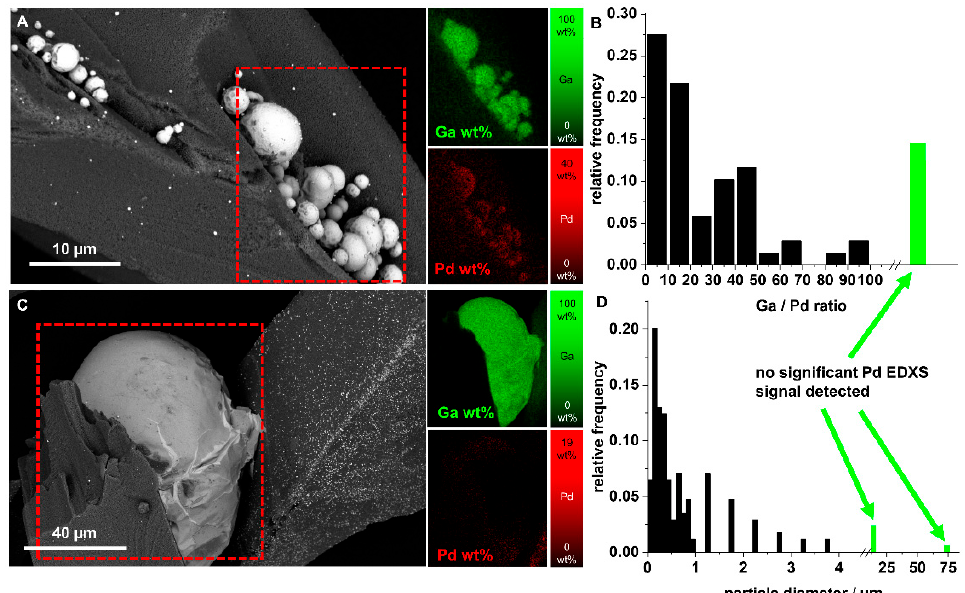
Figure 8. SEM-EDXS analysis of the surface area of a SCALMS primary particle. ( A ) SEM image (secondary electrons) of an exemplary sample area revealing spherically shaped Ga-Pd structures on the surface (bright contrast). The corresponding elemental maps for Ga (green) and Pd (red) reveal a high amount of Ga with dispersed Pd. ( B ) Bar plot displaying the relative frequency of surface droplets with a certain Ga/Pd ratio determined by SEM-EDXS (69 analyzed droplets). The Ga/Pd ratio varies between 3.00 and 95.83 (black bars). ( C ) SEM image of another region on the primary particle surface of an exemplary very large structure with a very high Ga/Pd ratio. ( D ) Particle size distribution of the Ga/Pd droplets on the surface determined from SEM images (169 analyzed droplets). The size varies quite significantly, and especially large structures (green bars) can be correlated to a very high Ga/Pd ratio.